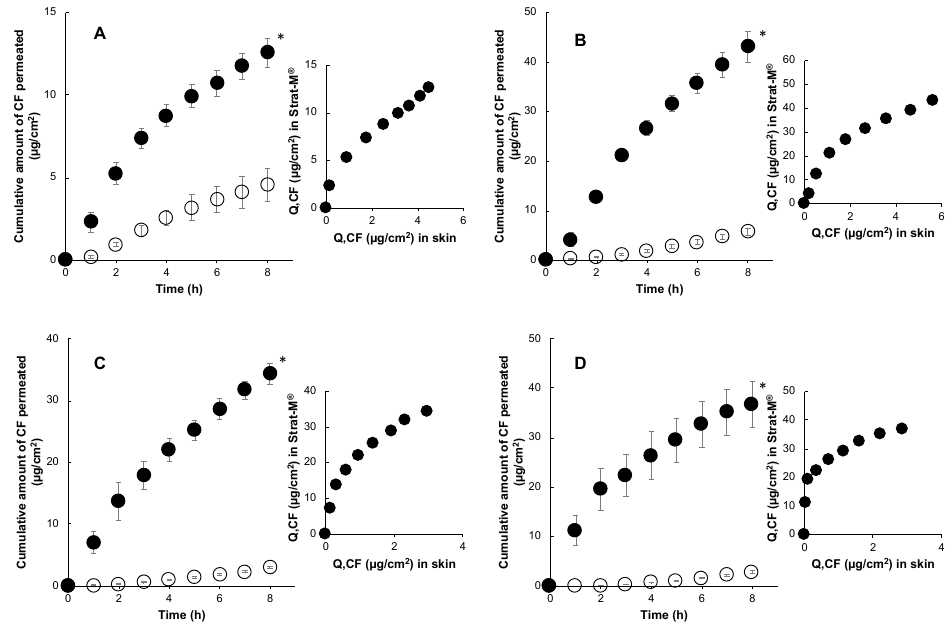
Figure 2. Time course of the cumulative amount of caffeine (CF) that permeated through Strat-M ® ( ● ) and porcine skin ( ○ ) and their correlations in in-use (finite dose) conditions (10 µL/cm 2 ). 1% CF in water ( A ), 1% CF in 50% polyol ( B ), 1% CF in 75% polyol ( C ), and 1% CF in 100% polyol ( D ). Each point represents the mean ± S.E. ( n = 4). Significant difference (* p < 0.05) between RD permeation through Strat-M ® and porcine skin.